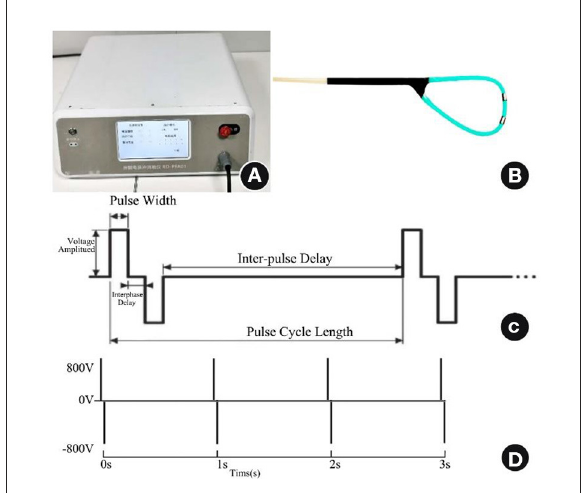
FIGURE1 PEF ablation instrument, ablation electrode catheter, and PEF ablation parameters. (A) PEF ablation instrument. (B) PEF ablation electrode under direct epicardial vision. (C) Biphasic PEF ablation parameters. (D) Fifty to one hundred pulse numbers delivered at a frequency of 1Hz. PEF, Pulsed electric